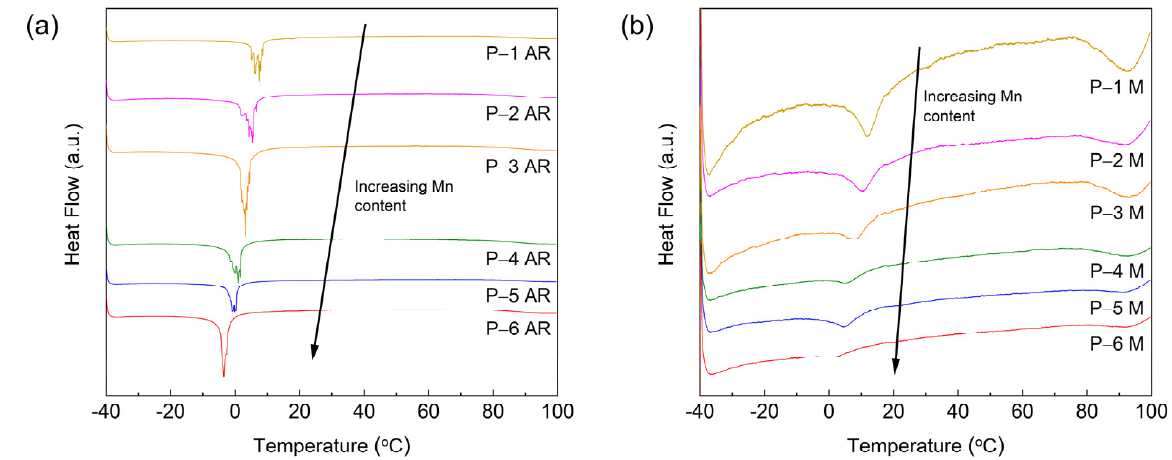
Figure 6. The heat flow as a function of the temperature ( − 40 to 100 °C) for the ( a ) as-received (ground) P-1 AR–P-6 AR and ( b ) milled P-1 M–P-6 M powders.